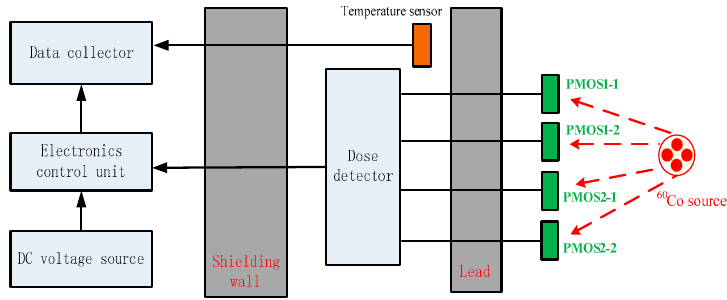
Figure 6. The scheme of the dose calibration test.